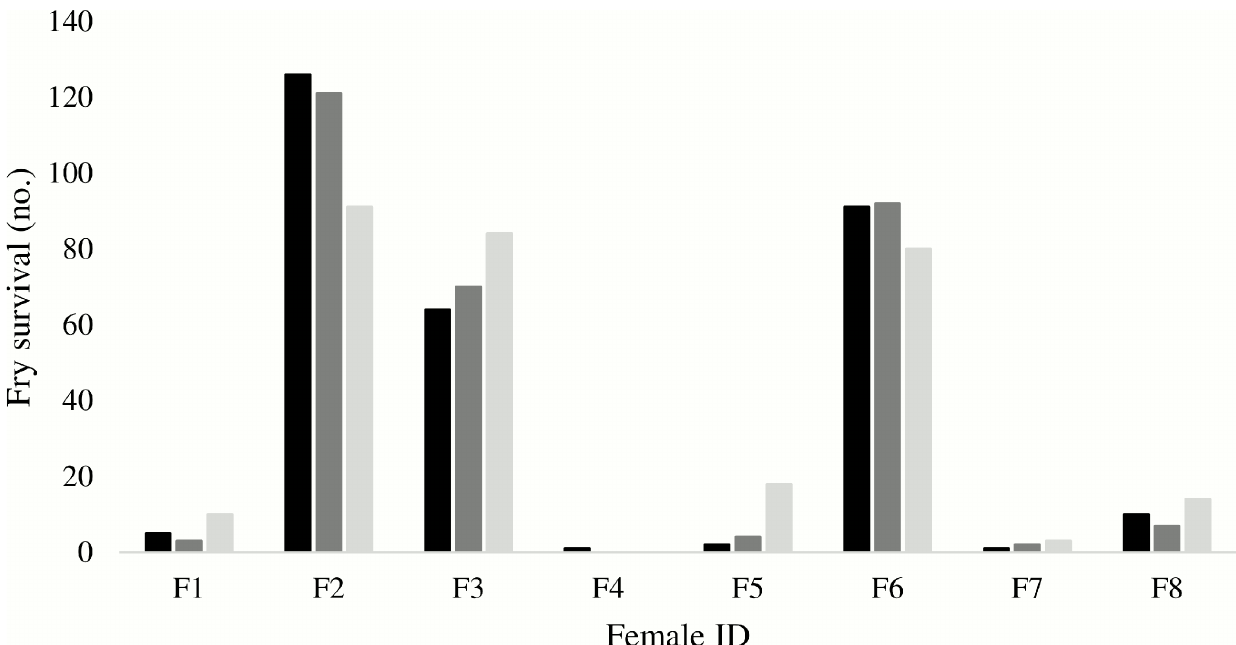
Fig 1. Survival numbers of post-metamorphosis progeny per replicate tank. Black, dark grey and light grey bars represent tank 1, 2 and 3, respectively.